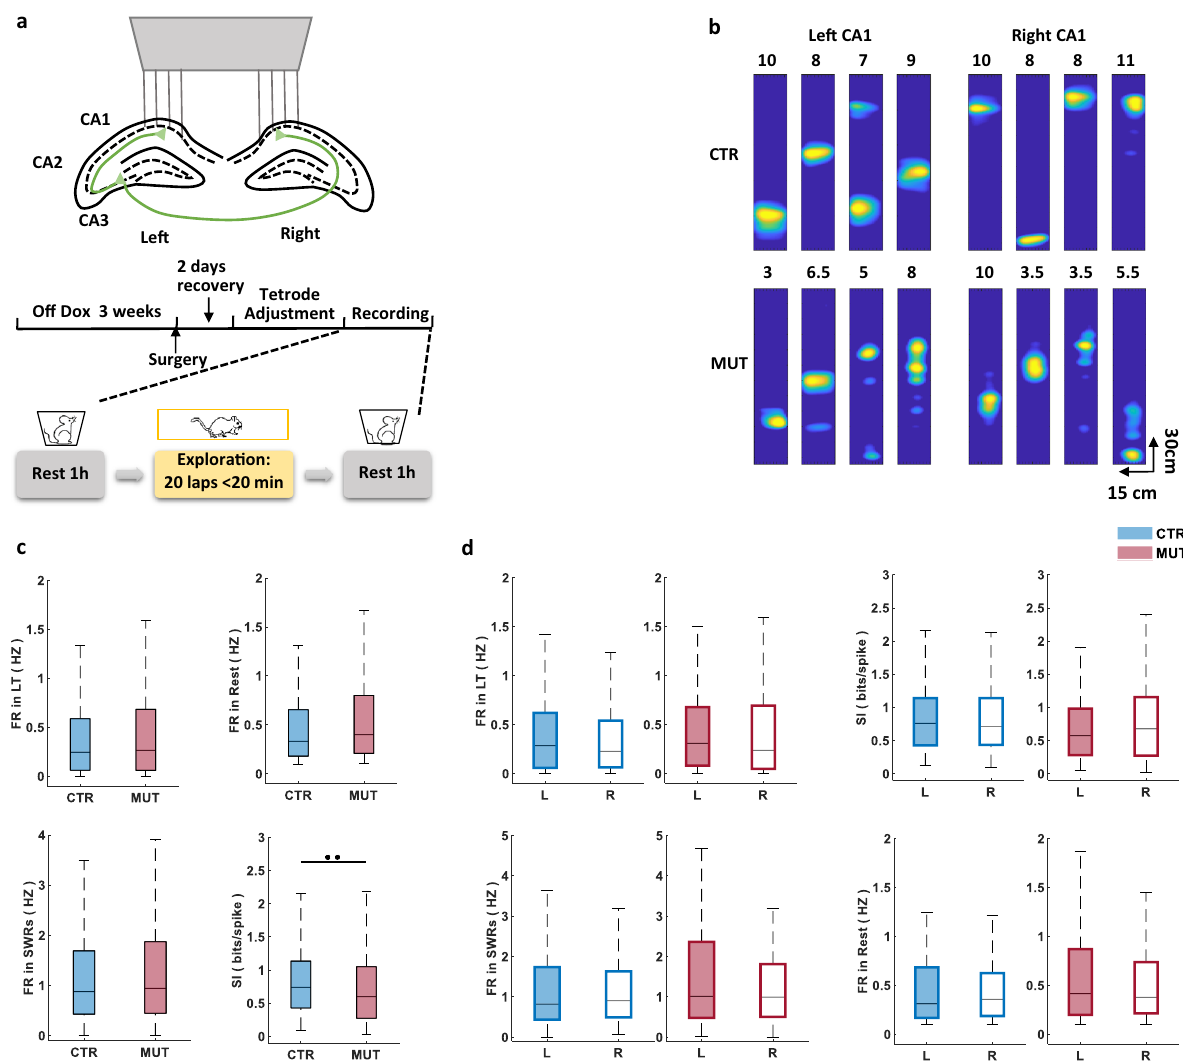
Fig. 1 Pyramidal cell properties remain similar across bilateral CA1 after silencing CA3. a Schematic representations of experimental protocols. Top: microdrive placement for bilateral CA1 recording; center: timeline of Dox food withdrawal, surgery, and recording; bottom: structure of the recording day. b Representative examples of fi ring rate maps on the linear track from the left and right CA1 of controls (CTRs) and mutants (MUTs). Colors are scaled to peak fi ring rate (Hz) indicated at the top of each map (blue, minimum; yellow, maximum). c Mean fi ring rate during exploration (CTR, N = 4 animals, n = 273 cells; MUT, N = 5 animals, n = 318 cells; P (mean fi ring rate during exploration) = 0.1939), rest and within SWRs was comparable between genotypes (CTR, N = 4 animals, n = 227 cells; MUT, N = 5 animals, n = 290 cells; P (mean fi ring rate during rest) = 0.1167; P (mean fi ring rate during SWRs) = 0.6285). Spatial information during exploration was signi fi cantly lower in mutants (CTR, N = 4 animals, n = 273 cells; MUT, N = 5 animals, n = 318 cells; P = 0.0046). d Pyramidal cell properties were comparable between the left and right CA1 ( fi lled bars: left hemisphere; open bars: right hemisphere; CTR, N = 4 animals, n (left) = 152 cells, n (right) = 121 cells; MUT, N = 5 animals, n (left) = 162 cells, n (right) = 156 cells; mean fi ring rate during exploration: P (CTR) = 0.6816, P (MUT) = 0.1030; spatial information during exploration: P (CTR) = 0.8559, P (MUT) = 0.5042; during sleep: CTR, N = 4 animals, n (left) = 126 cells, n (right) = 101 cells; MUT, N = 5 animals, n (left) = 158 cells, n (right) = 132 cells; mean fi ring rate during rest: P (CTR) = 0.5773, P (MUT) = 0.5291; mean fi ring rate during ripple: P (CTR) = 0.2369, P (MUT) = 0.0676); signi fi cant difference in Fig. 1d were tested